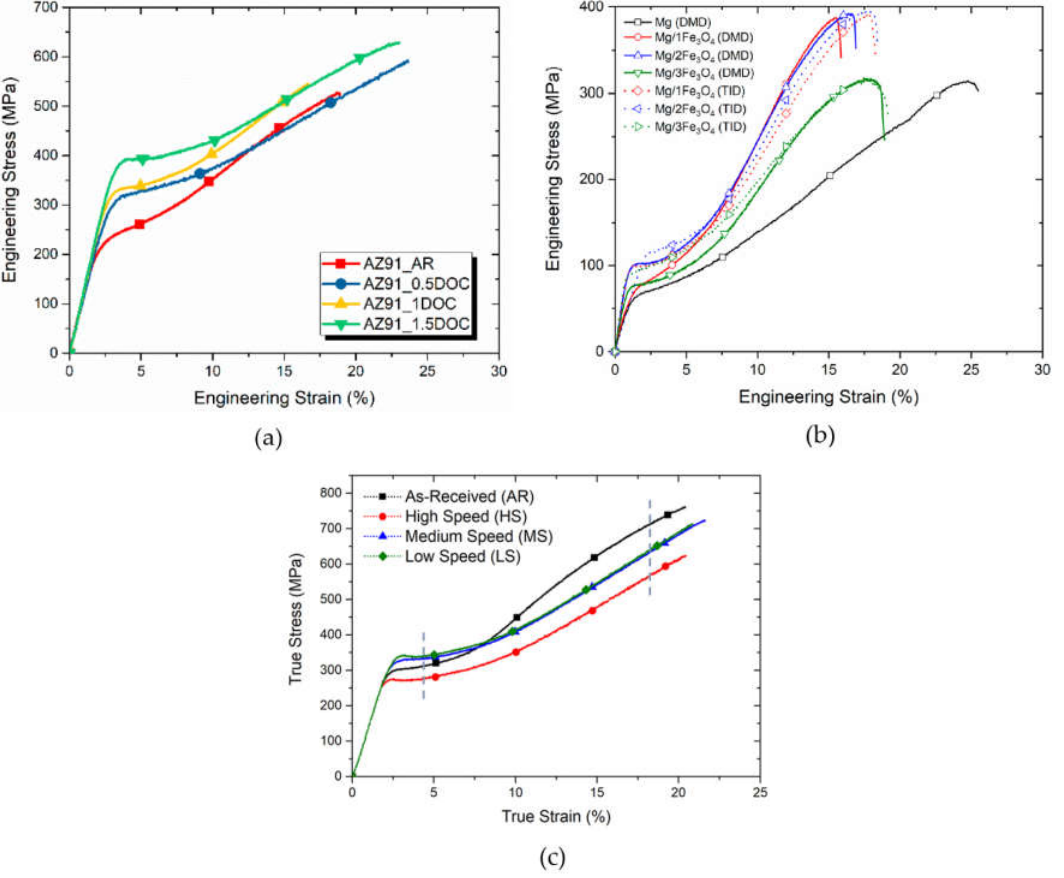
Figure 4. Compressive stress–strain charts associated with TID Mg materials and their improvement over conventionally- processed materials for ( a ) AZ91 alloy, ( b ) Mg/Fe 3 O 4 nanocomposites, and ( c ) ZK60 alloy [18,24,25].